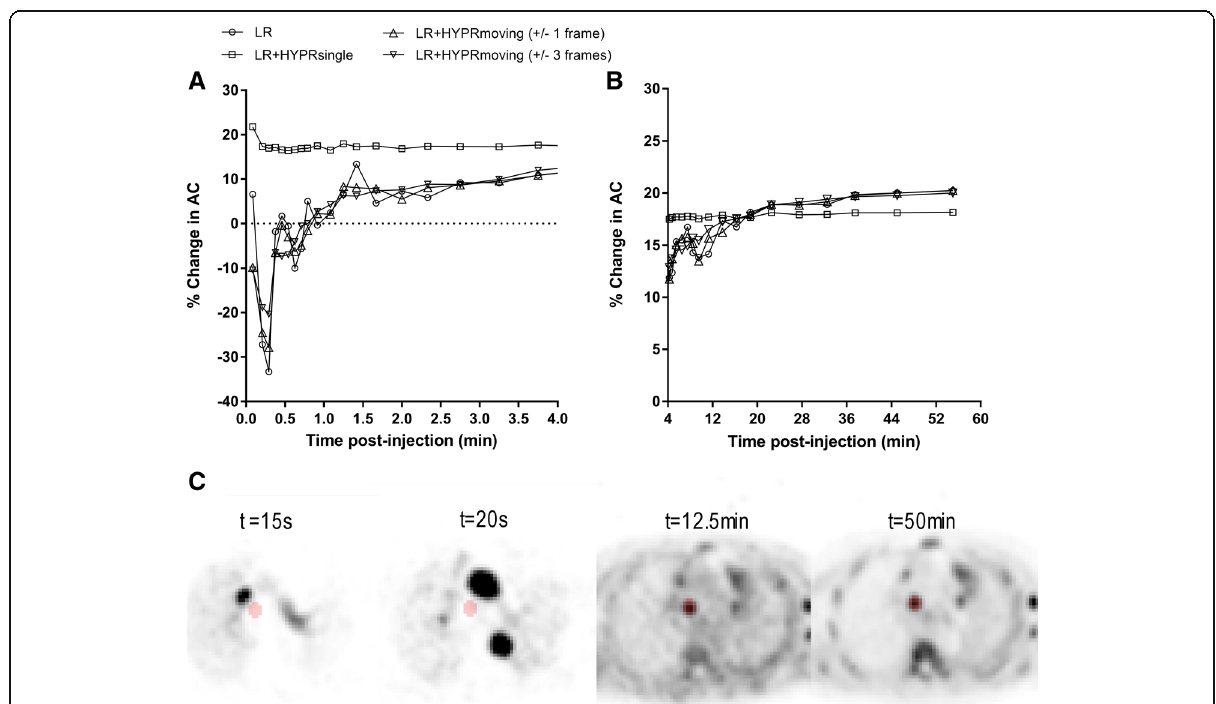
Fig. 1 Time-activity curves of relative change in activity concentrations (AC) after PVC using several HYPR settings. Frames of 0 – 4 min ( a ) and 4 – 60 min ( b ) post-injection. Results of a typical mediastinal lymph node metastasis are shown. Note the temporality of PVE with a spill in at early timeframes. Corresponding original PET images ( c ) with the lesion volume-of-interest in red demonstrate blood pool activity near the VOI and increasing tumor-to-background contrast over